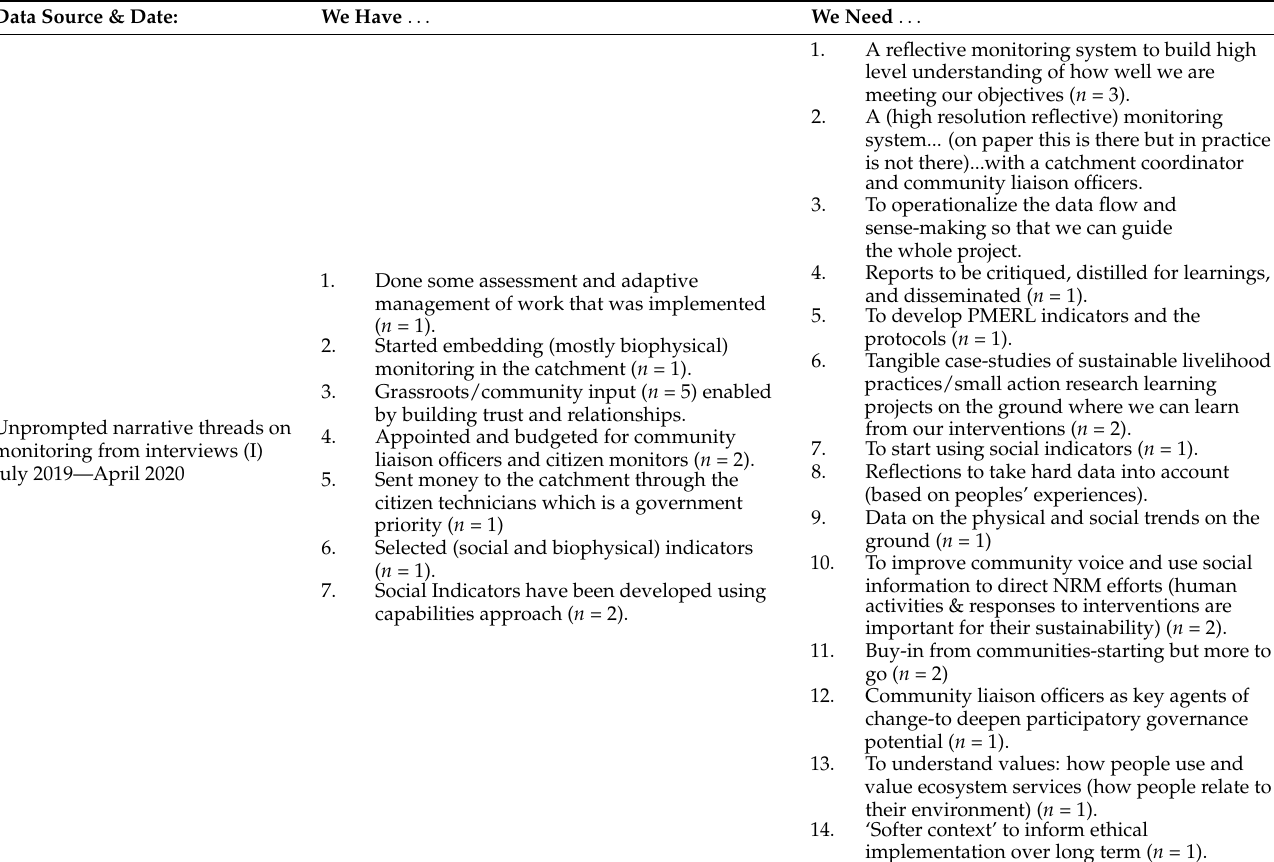
Table 3. Data reported on ‘Monitoring’ during various phases of the participatory self-observation process in the Tsitsa Project. The data were categorized into achievements, placed in the “We have . . . ” column, and gaps placed in the “We need . . . ” column. We Have . .